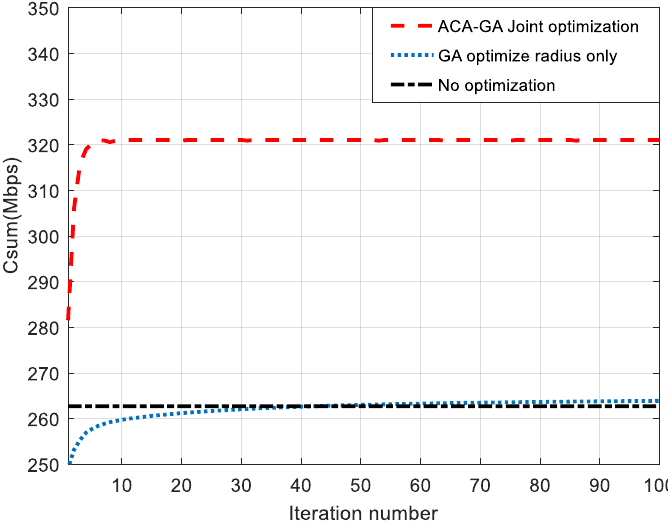
ff erent optimization methods ( N = C in three different optimization methods ( =20 N ). Figure 7. Throughput C sum in three di sum C in three different optimization methods ( =20 N ). sum